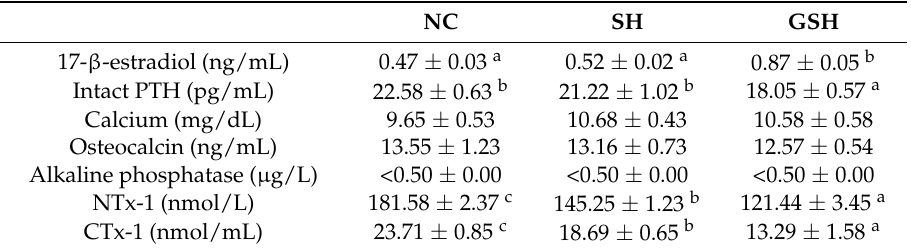
Table 5. Biochemical markers of bone metabolism in ovariectomized rats fed with germinated Superhongmi rice